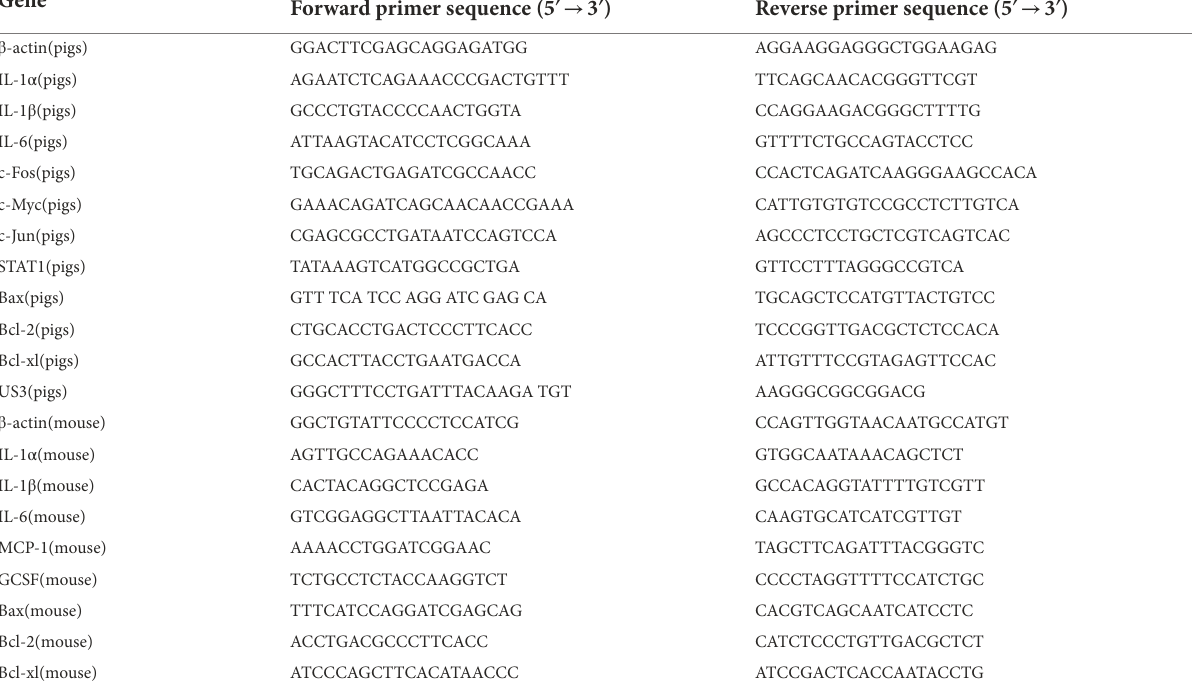
TABLE 1 The primer sequences used for real-time PCR. Gene Forward primer sequence (5